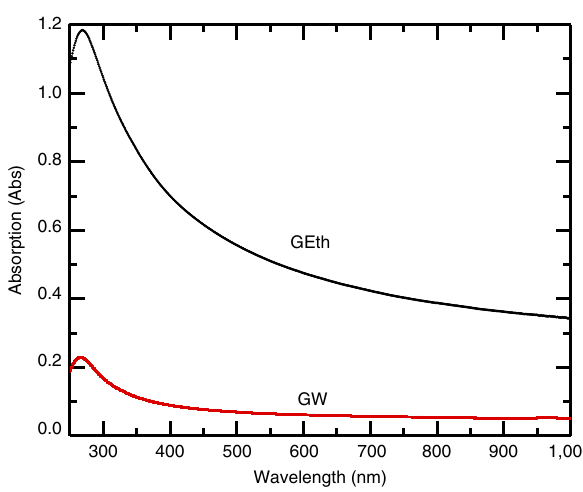
Figure 1 | Absorption spectra. Absorption of water-based (GW) and ethanol-based (GEth) inks from the visible to near-infrared range.